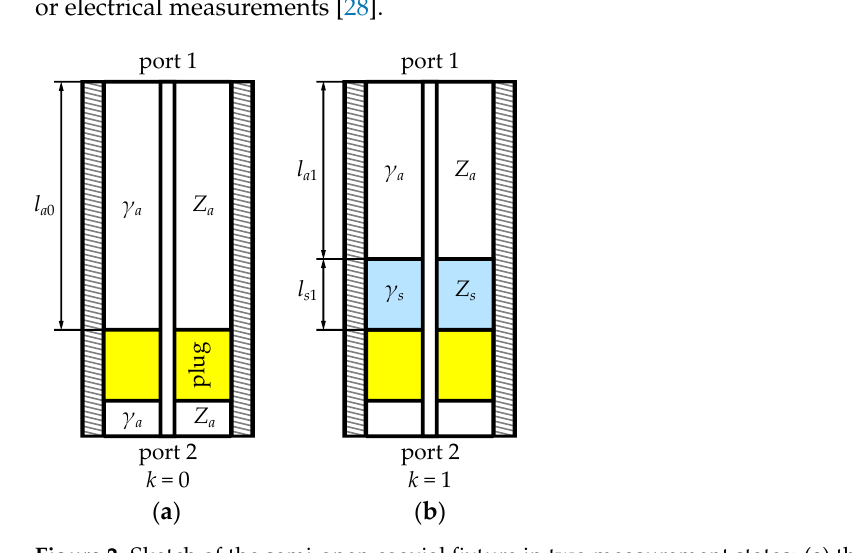
Figure 2. Sketch of the semi-open coaxial fixture in two measurement states: ( a ) the empty cell; ( b ) the cell filled with the ring sample of liquid with the ideally flat upper surface. List of symbols: l ak —the length of k -th airline section; l s 1 —the height of the sample; Z a , Z s —characteristic impedances and γ a , γ s —propagation constants for the air and sample,